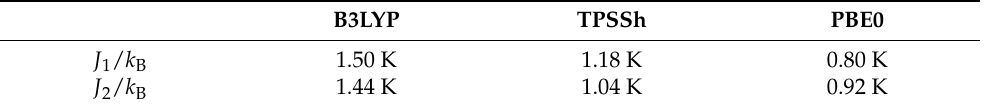
Table 1. Comparison of the exchange coupling in NiHmal obtained from BS DFT calculations for two different exchange paths using selected DFT functionals. B3LYP TPSSh PBE0 J 1 / k B 1.50